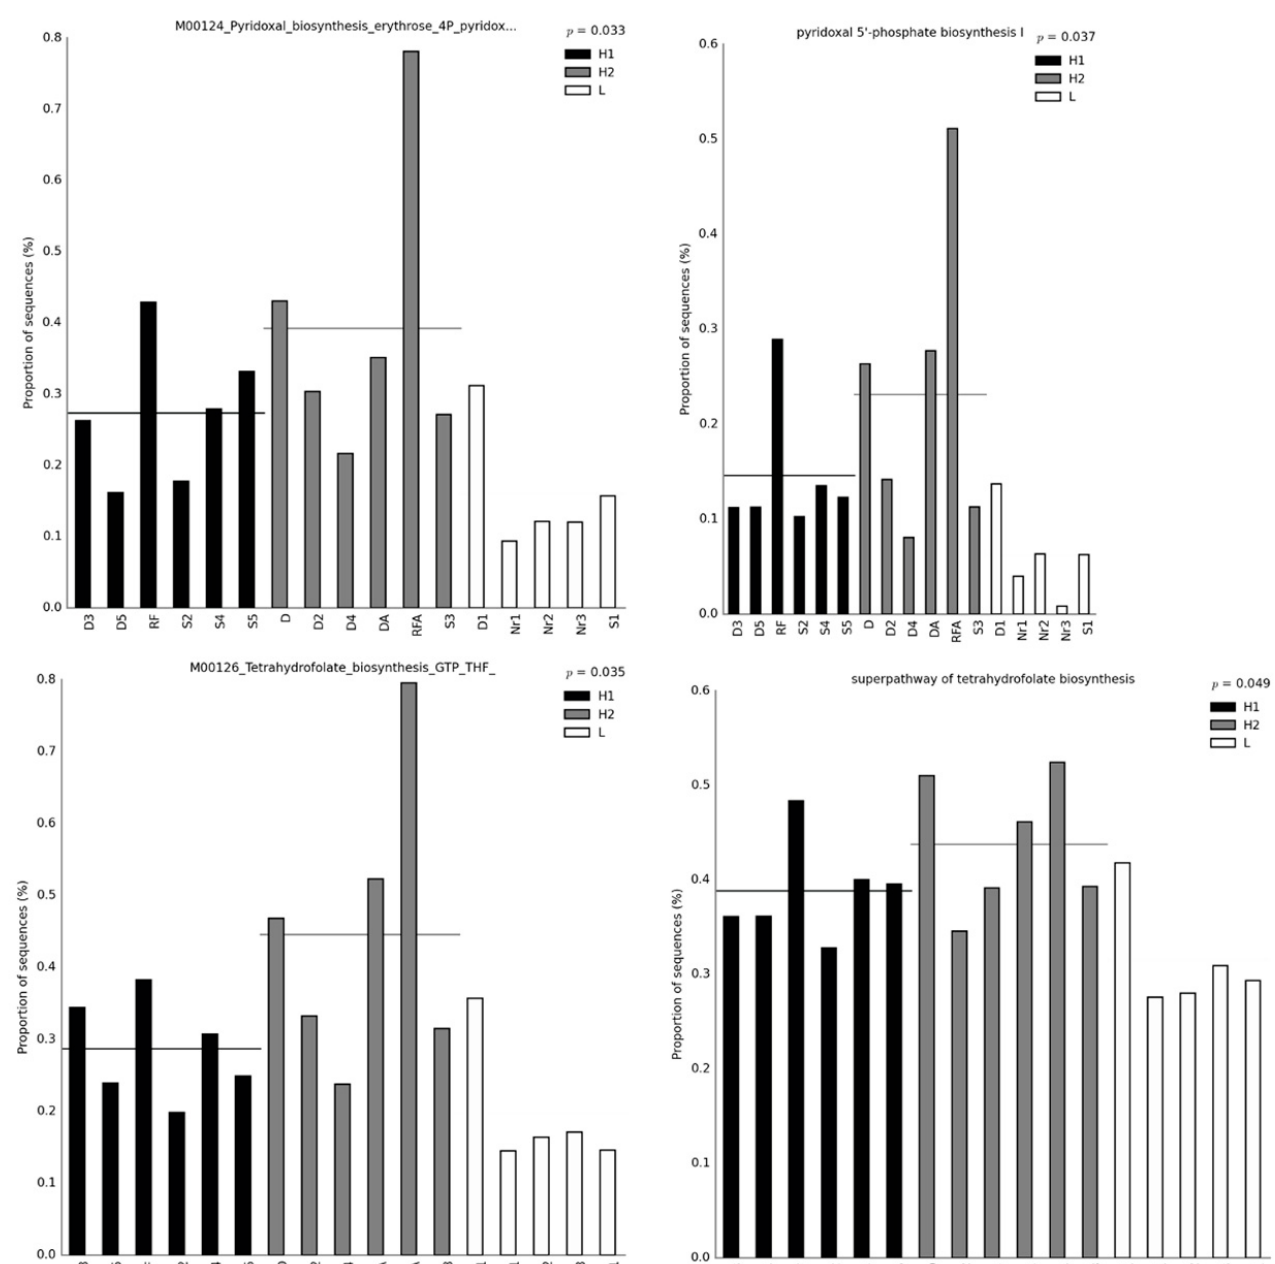
8 of 13 Figure 3. Bar plots of the functional features related to energy metabolism. The x-axis indicates